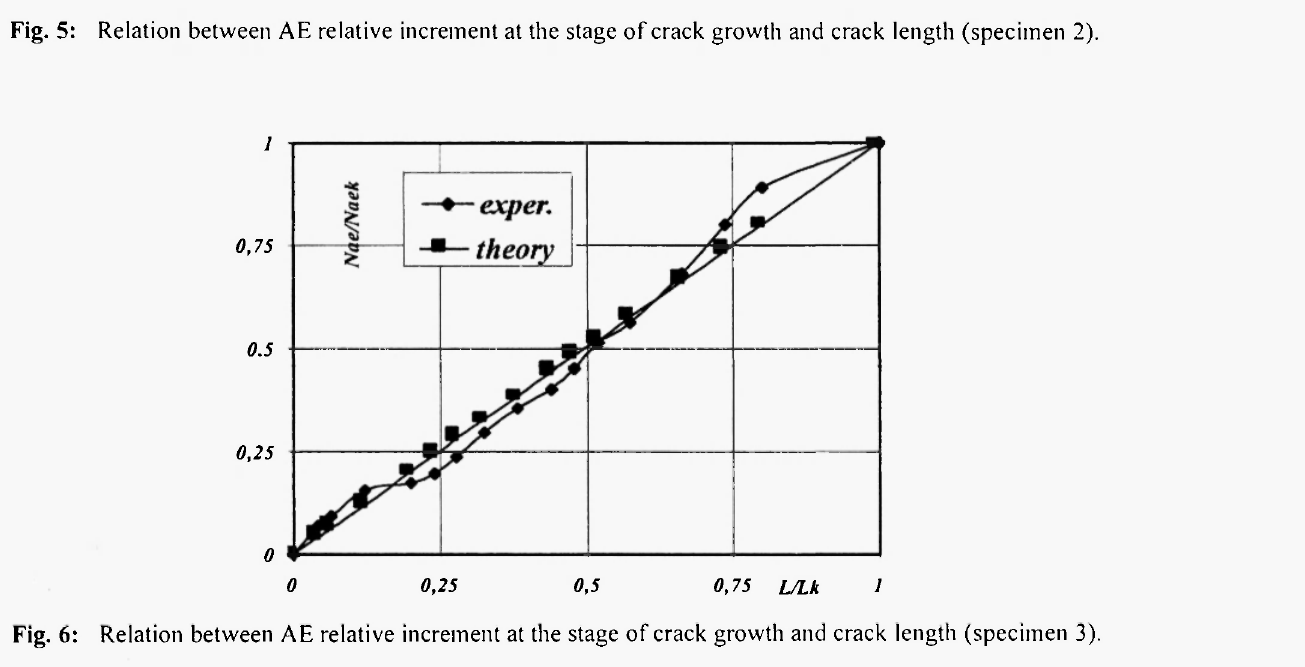
Fig. 6: Relation between AE relative increment at the stage of crack growth and crack length (specimen